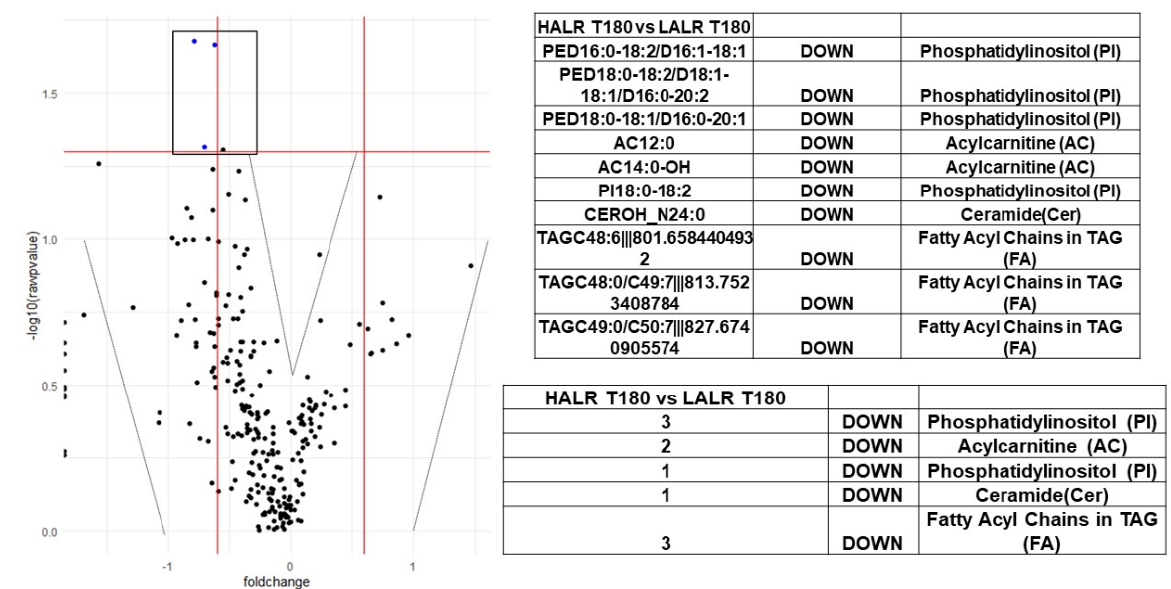
Figure 3. Volcano plot with differences in lipidomic signatures for Time 180 ′ (peak of postprandial response) after a mixed meal among participants with (H) vs. (L)ALR. Individual lipid classes and species are shown in boxes (right). Table 6. Contrast linear combination of variables between the CG and RG (N =